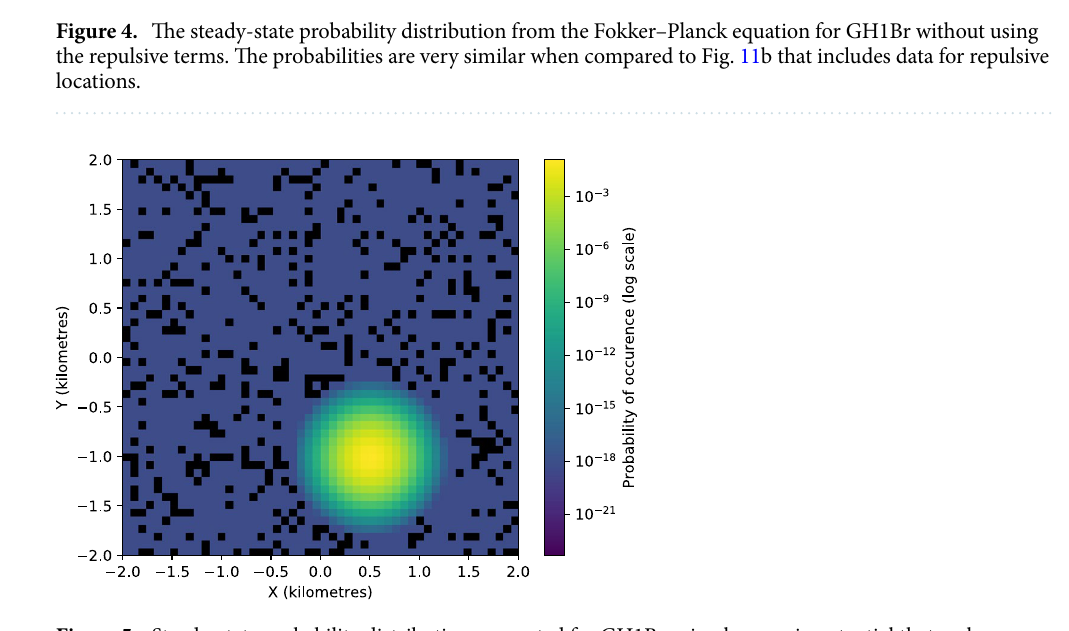
1 km, Y 2 km) apart from the nest = =